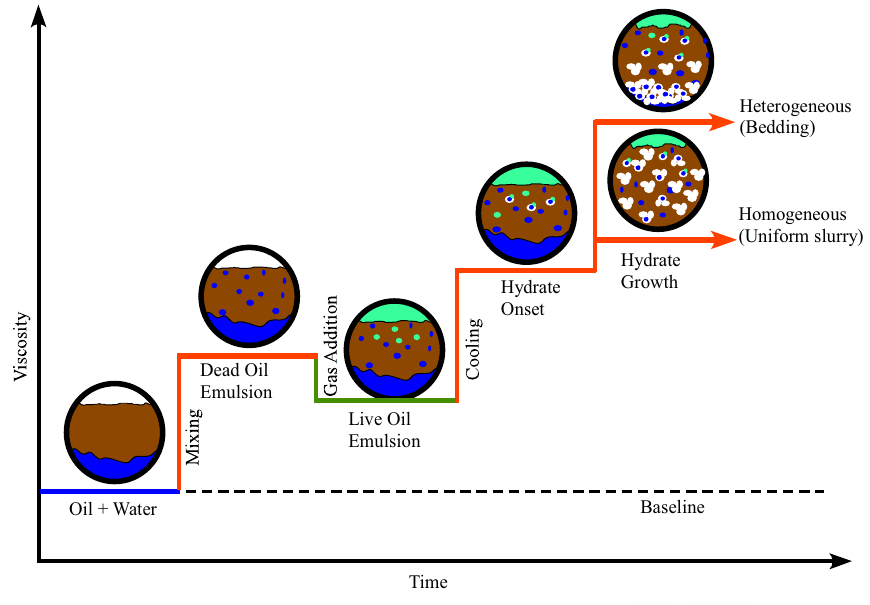
Fig. 6 Hypothetical torque response during hydrate forma-